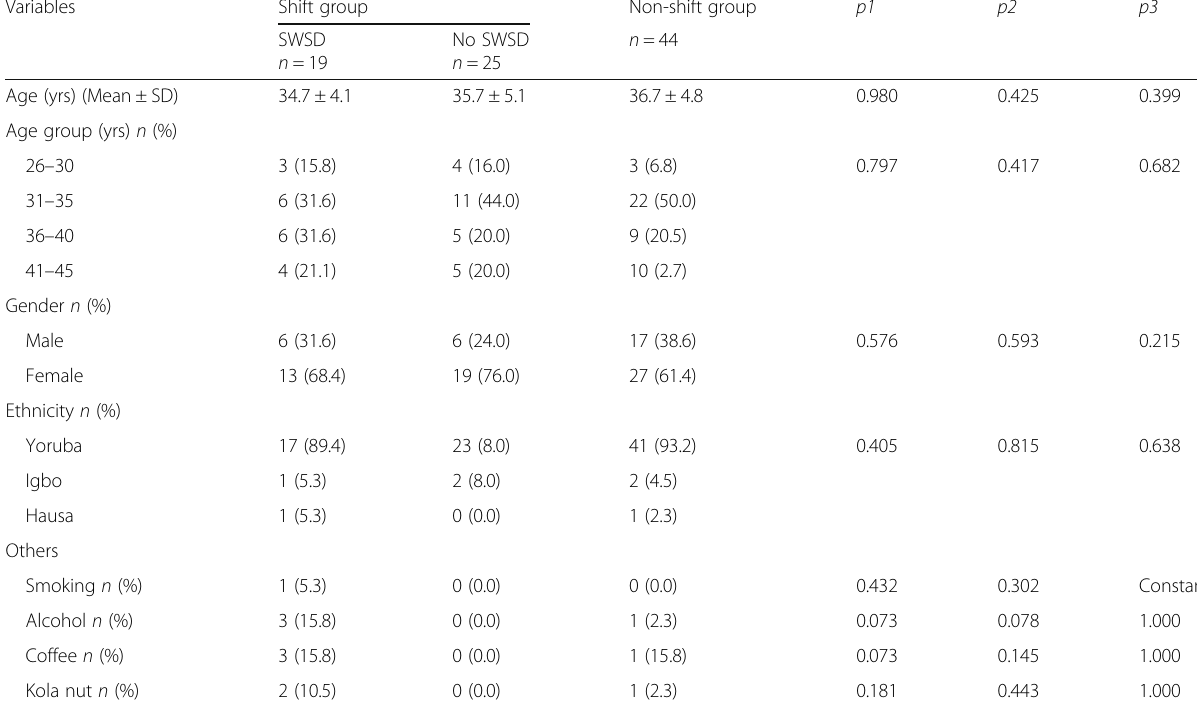
Table 1 Comparison of socio-demographic characteristics between SWSD, No SWSD and non-shift group Variables Shift